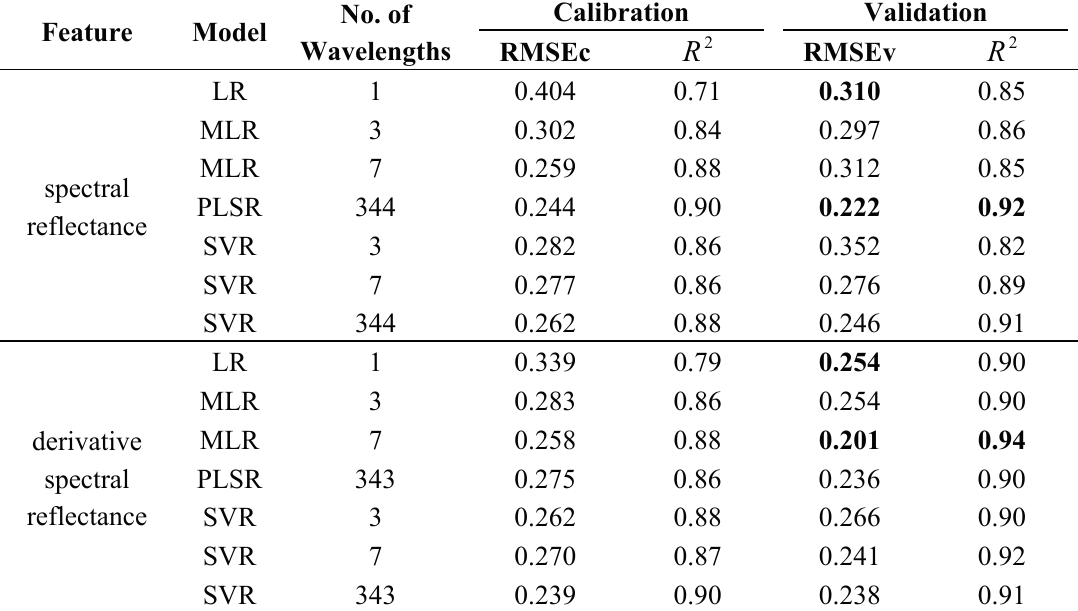
Table 2. Spectral variables and chlorophyll content retrieval accuracies for the different models (FISS data) ( RMSEc refers to RMSE of calibration dataset and RMSEv refers to RMSE of validation dataset)